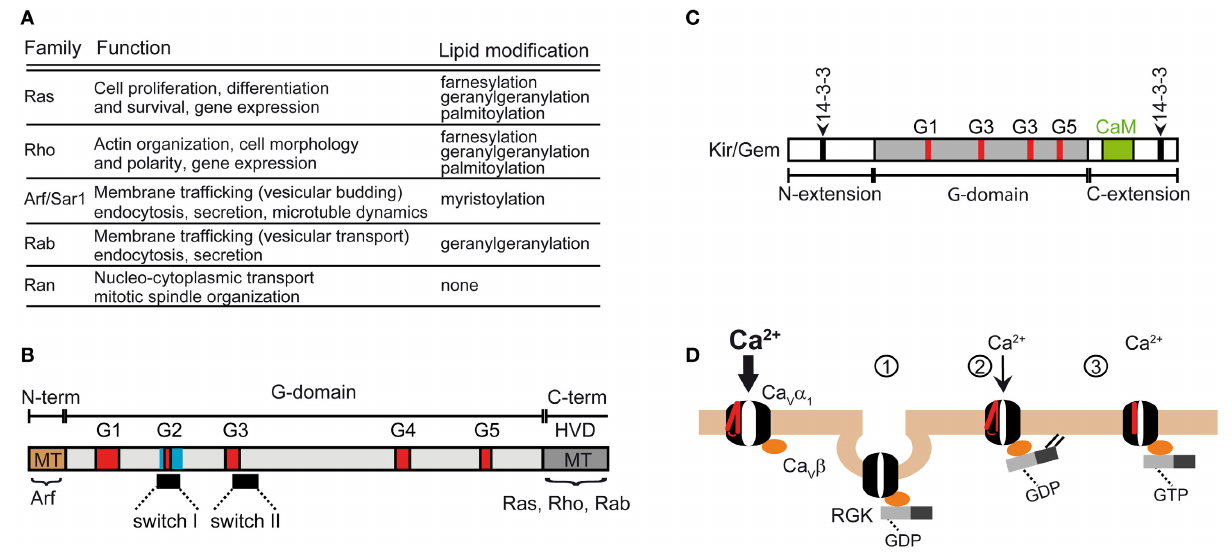
FIGURE 5 | Functions of the Ras superfamily of small GTPases. (A) Subfamilies andfunctions oftheRassuperfamily (reviewed inVigilet al.,2010). (B) Domain structure shared by the Ras superfamily. The shared feature is the G-domain containing several GDP/GTP binding motifs (labeled G1 to G5). The Ras superfamily encompass a highly variable C-terminal domain (HVD) that includes the membrane targeting domain (MT) which undergoes lipid modification in Ras, Rho and Rab subfamilies. MT in Arf subfamily is at the N-terminus. (C) Domain organization of RGK GTPases. Note that the G domain differs from the canonical one shared by the other members of the Ras superfamily. Besides the Ca 2 + /calmodulin binding site (CaM), RGKs also